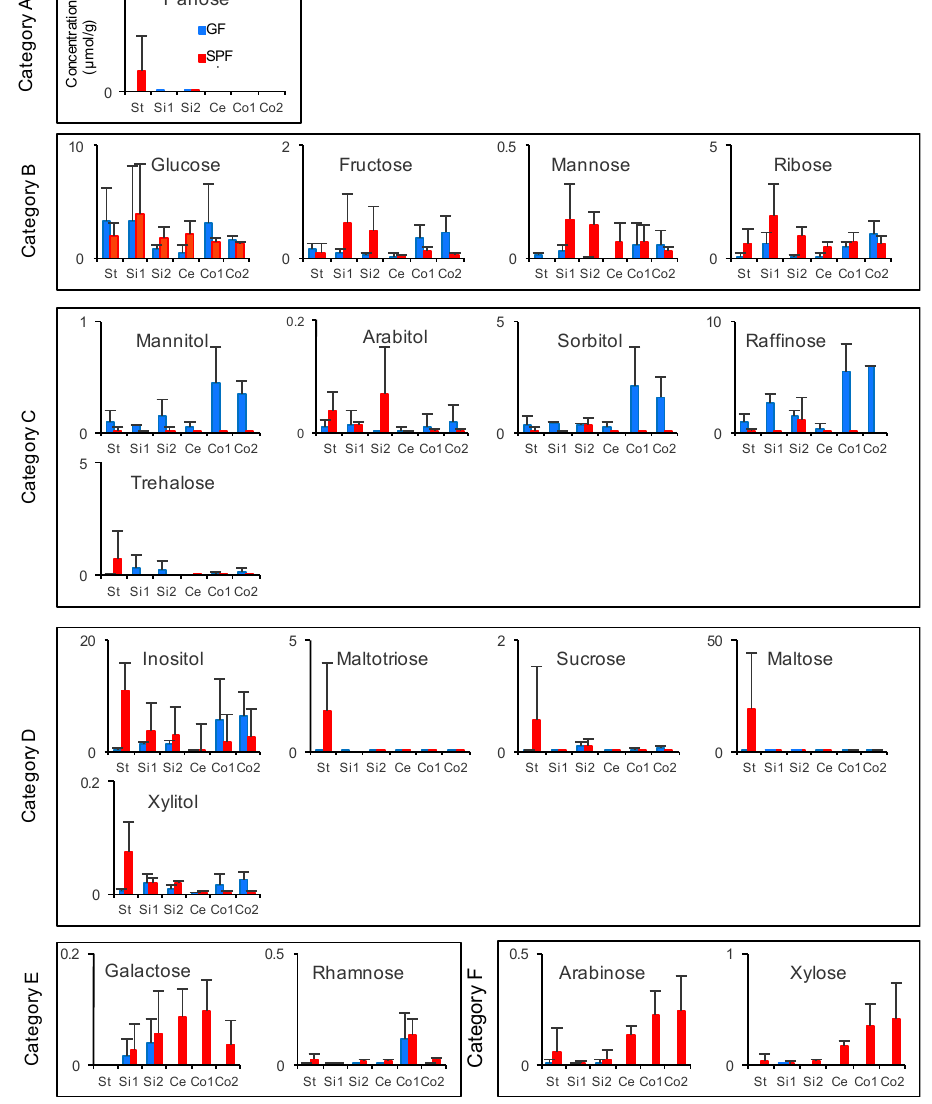
Figure 5. Luminal carbohydrate profiles of the gastrointestinal tract of SPF and GF mice. Line graphs show the average concentrations of carbohydrates in the gastrointestinal contents. The red and blue lines indicate SPF and GF mice, respectively. The error bars represent the standard error ( n = 3). St: Stomach, Si1: Upper small intestine, Si2: Lower small intestine, Ce: Cecum, Co1: Upper colon, Co2: Lower colon. Unit: µ